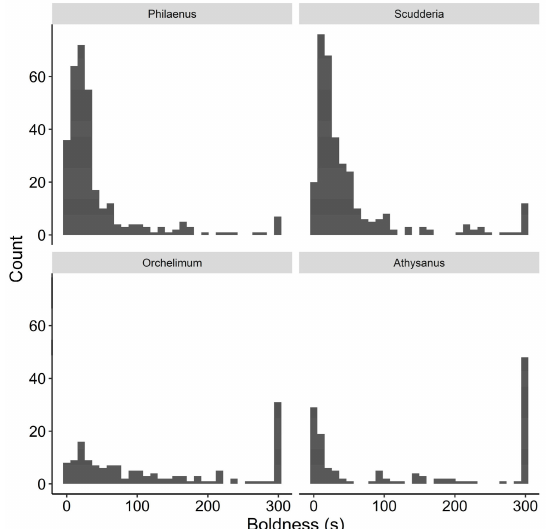
Figure 1. Histograms depicting boldness measurements for insect prey individuals used in the mesocosm experiment. Each mesocosm received 10 Philaenus individuals, 10 Scudderia individuals, 5 Orchelimum individuals, and 5 Athysanus individuals. Prey individuals were added haphazardly and blindly to mesocosms with respect to their individual behavior, generating naturally occurring behavioral variation within and across prey species’